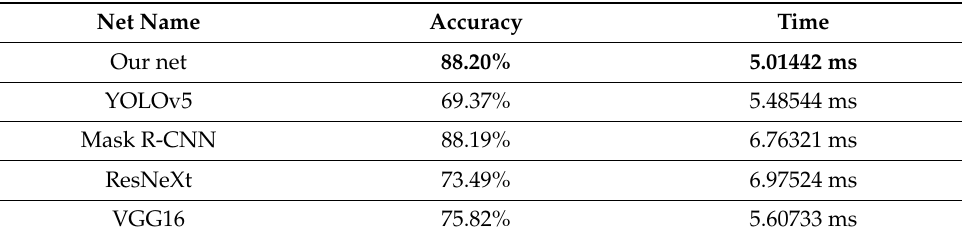
Table 4. Comparison of time and accuracy of classification of different networks. The best indicators for each class are highlighted in